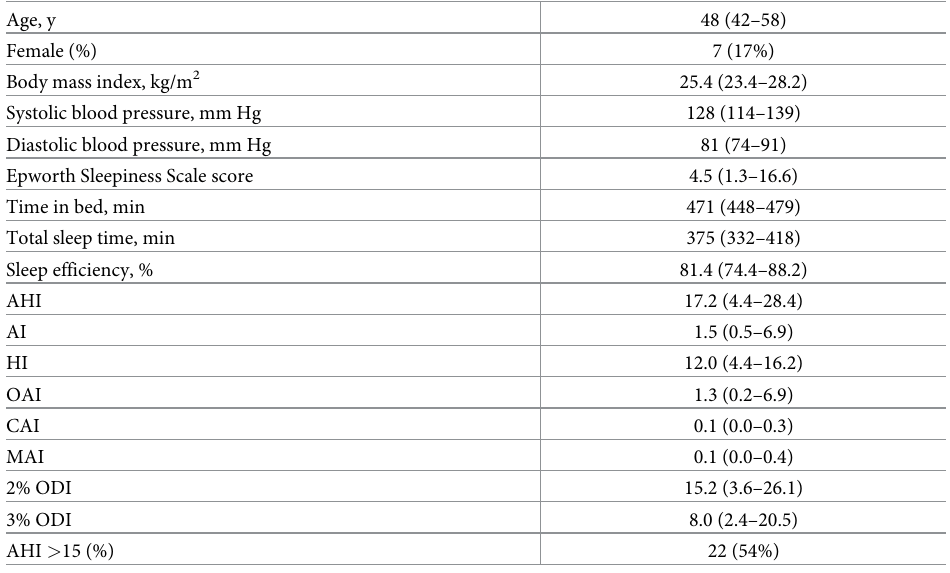
Table 1. Patients’ characteristics (n =